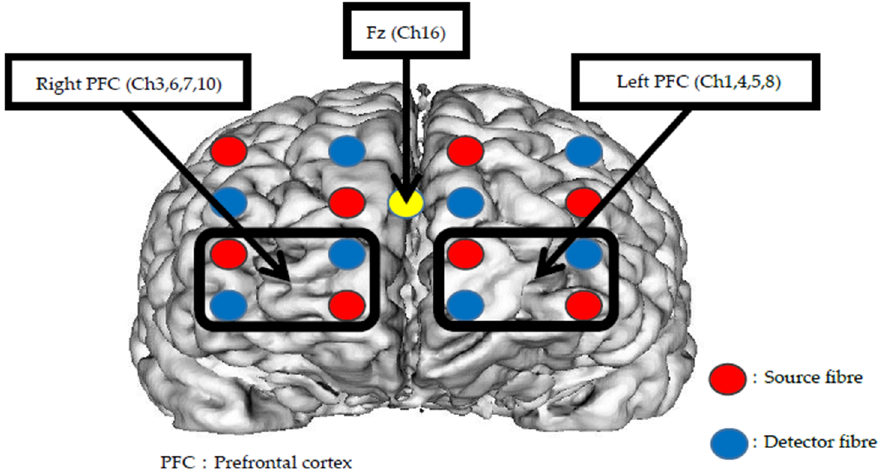
Figure 3. Measurement channels and fiber arrangement.